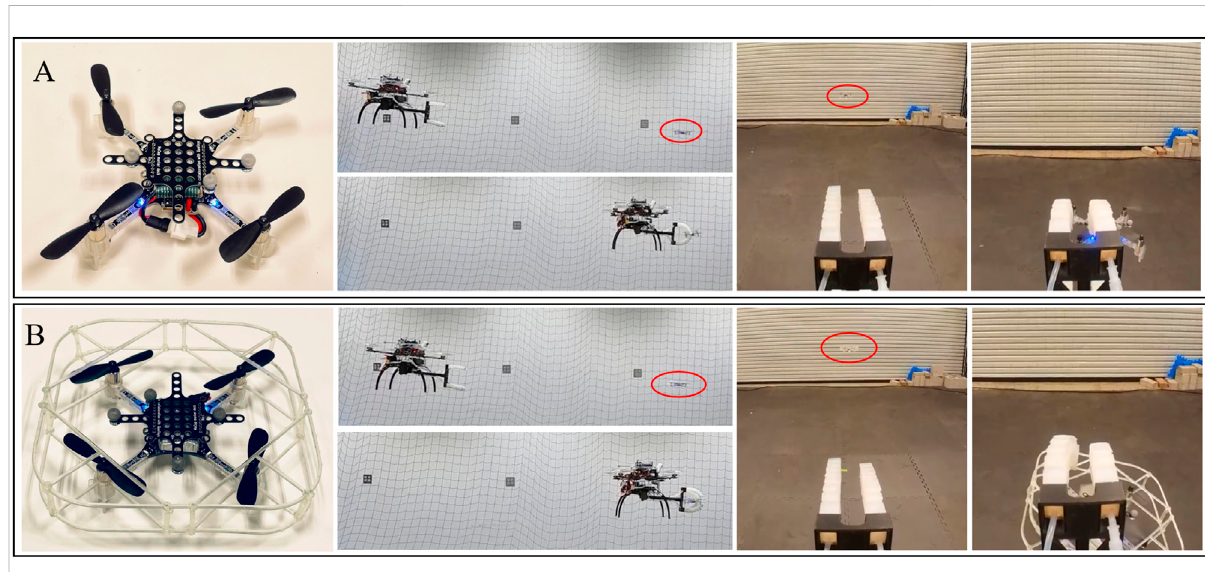
FIGURE 8 Close-up images of the fl ying targets without (A) or with (B) propeller guards, as well as side views and fi rst-person views of the aerial captures.